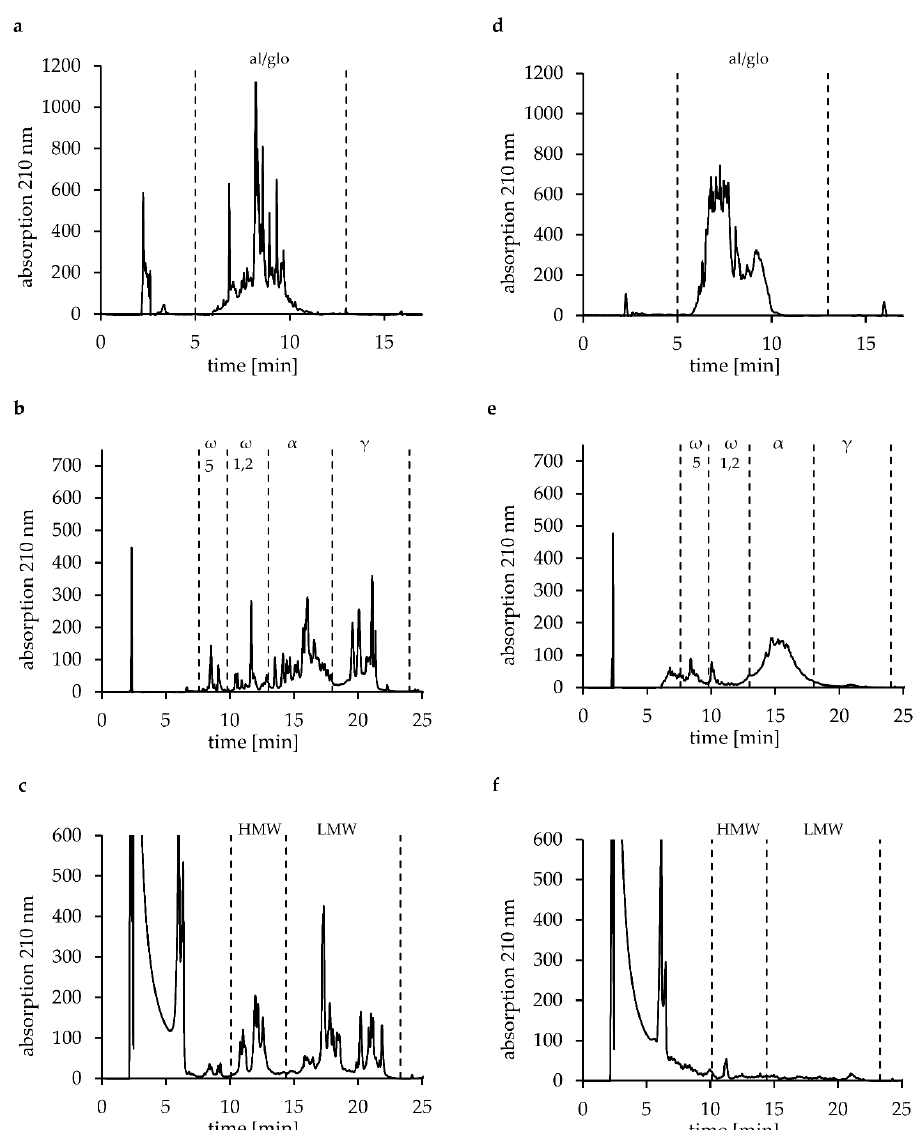
Figure 1. Reversed-phase high-performance liquid-chromatography: Chromatograms of the three fractions, soluble in aqueous salt solution (fraction A), soluble in 60% ethanol (fraction B), and soluble in glutenin extraction solution (fraction C) of gluten G1 ( a – c ) and hydrolyzed wheat protein HWP2 ( d – f ). Albumins and globulins (fraction A: a , d ), gliadins subdivided into ω 5-, ω 1,2-, α -, and γ -gliadins (fraction B: b , e ), and glutenins subdivided into high-molecular-weight- (HMW-)